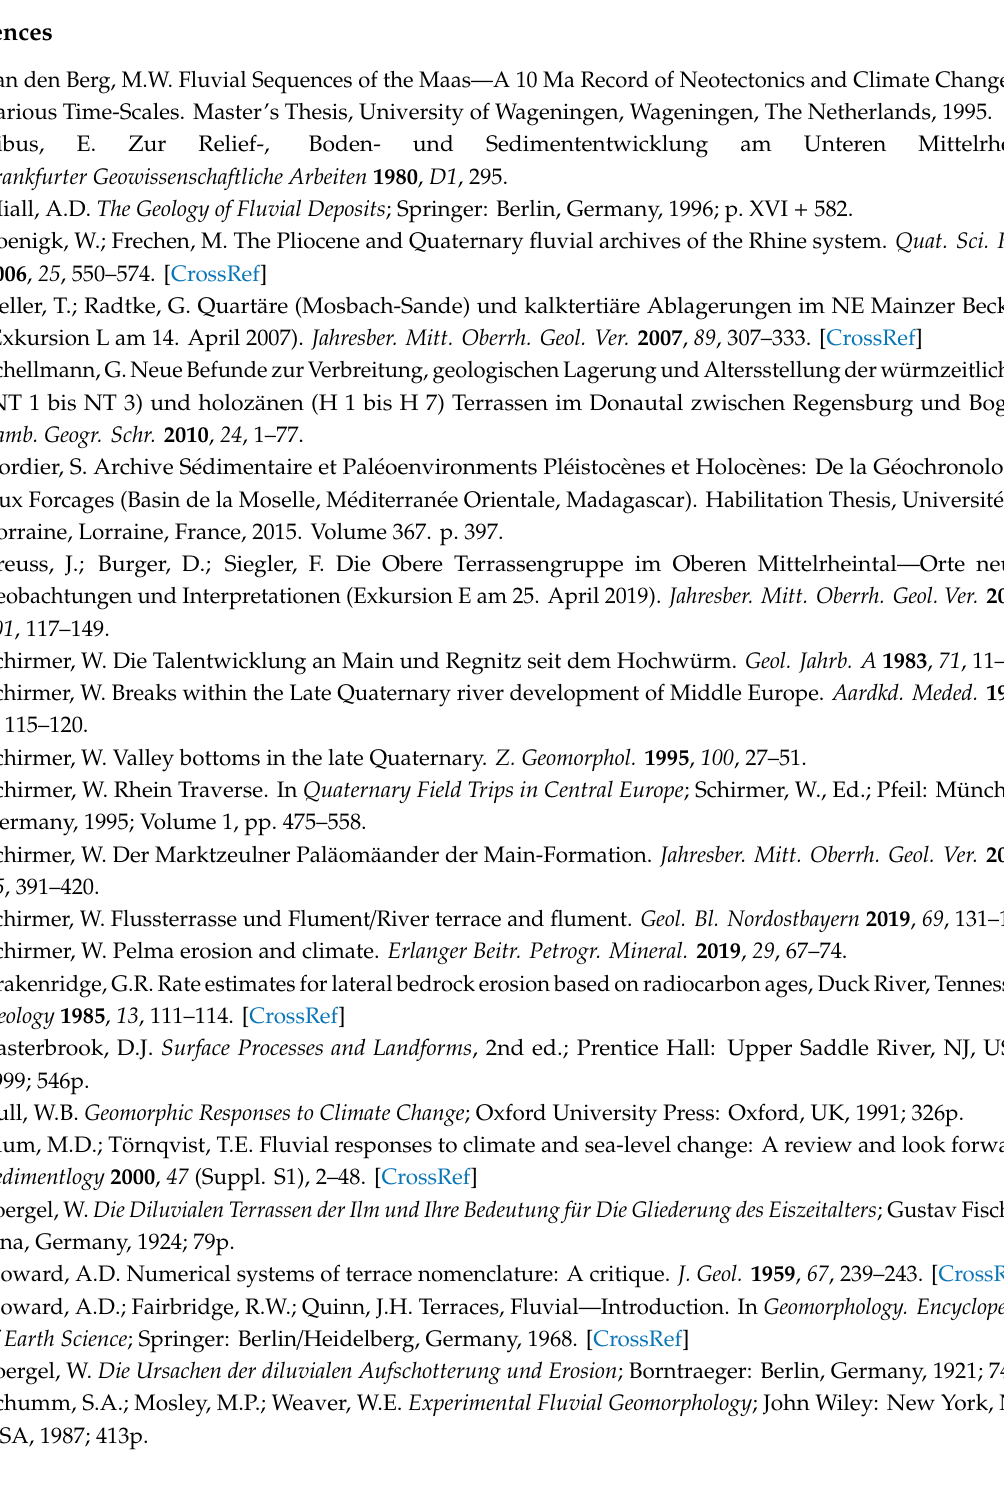
Table S1: Glossary of fluvial terms used in the